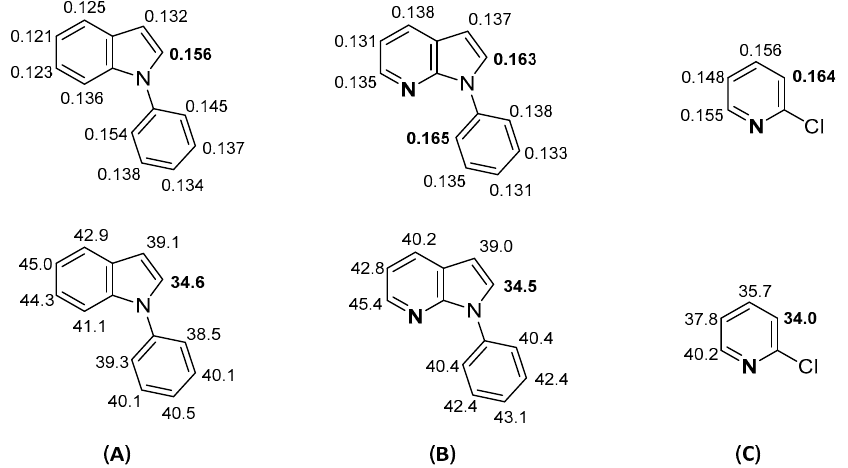
Figure 4. Calculated H charges (top) and p K a values (bottom) of 1-phenylindole [52] ( A ), 1-phenyl- 7-azaindole ( 1a ; B ) and 2-chloropyridine [53] ( C ). azaindole ( 1a ; B ) and 2-chloropyridine [53] ( C